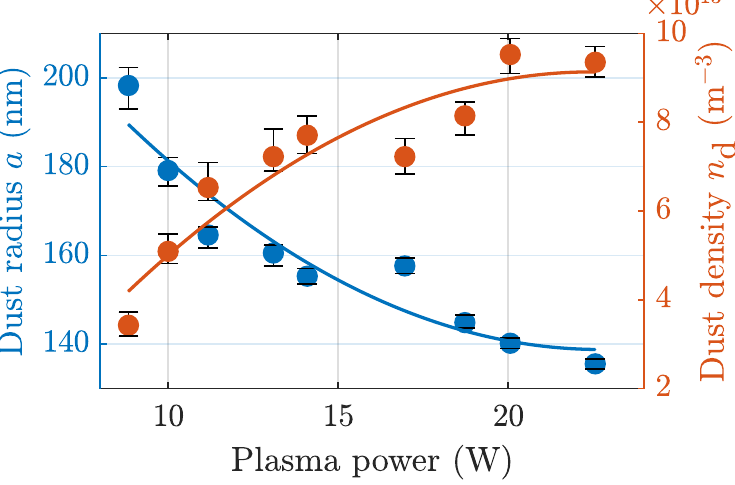
Figure 8. Overview of the results of the fitting procedure for the plasma power scan. The dust particle radius a (in blue circles) and the dust density n d , both at the moment of formation of the void, are plotted as a function of plasma power. The error bars are the result of the errors in the measured electron density ˆ n e and transmittance ˆ T , as propagated through the fitting procedure. Again, a constant value of the electron temperature T e = 3eV and the negative ion density n i − = 4 n e,initial are